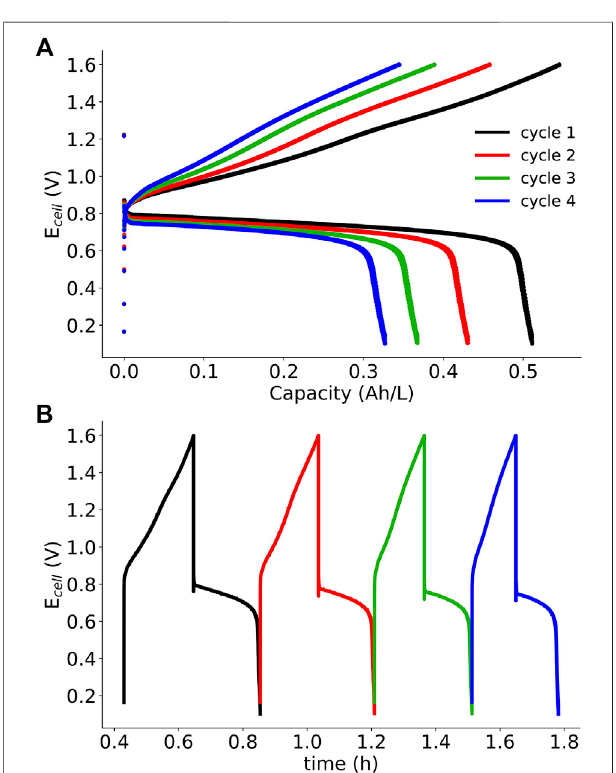
FIGURE 8 | SDS microemulsion RFB galvanostatic cycling data (5 mA · cm − 2 ) for four cycles: (A) E cell vs capacity and (B) E cell vs time. SDS microemulsions are 8.75% SDS 8.75% 1-butanol, 52.5% 0.5 m KNO 3 (aq), and 30% redox active species/toluene solution. Ferrocene (192 mM) andmenadione(89 mM)weretheposolyteandnegolyteredoxactivespecies,